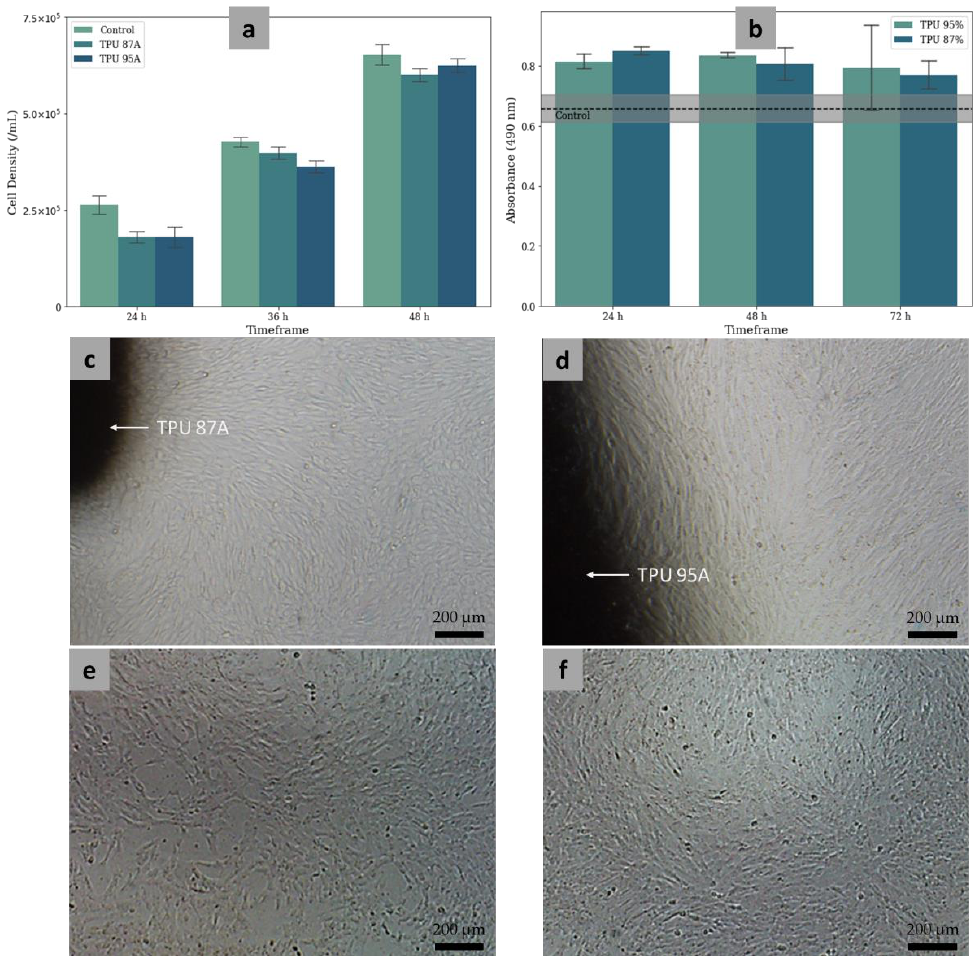
Figure 11. Direct ( a ) and indirect ( b ) cytotoxicity assay results. Microscopic photographs of MSCs in the vicinity of TPU 87A ( c ) and TPU 95A ( d ) in a 6-well plate after 3 days of incubation and before the direct assay. Microscopic photographs of MSCs in the 96-well plates containing TPU 87A ( e ) and TPU 95A ( f ) after 3 days of incubation and before the MTS assay.